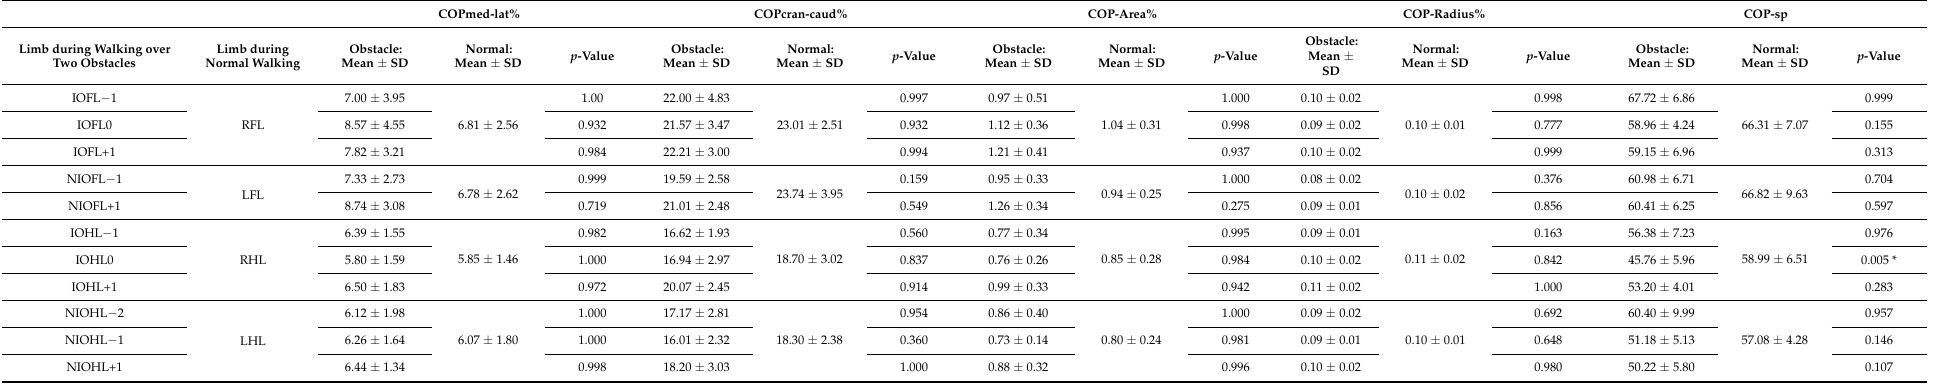
Table A4. Mean values, standard deviations, and significant differences in COP values between walking over two obstacles and normal walking.